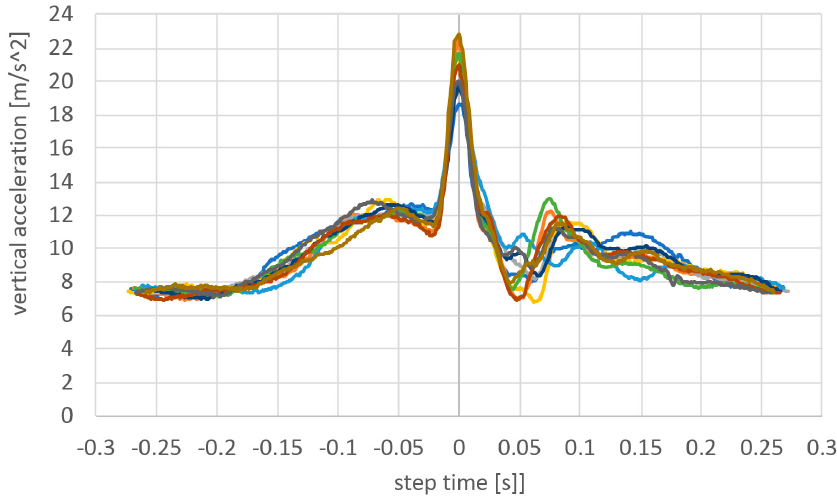
Figure 29. The vertical component of the head acceleration during 10 subsequent steps of the single passage.